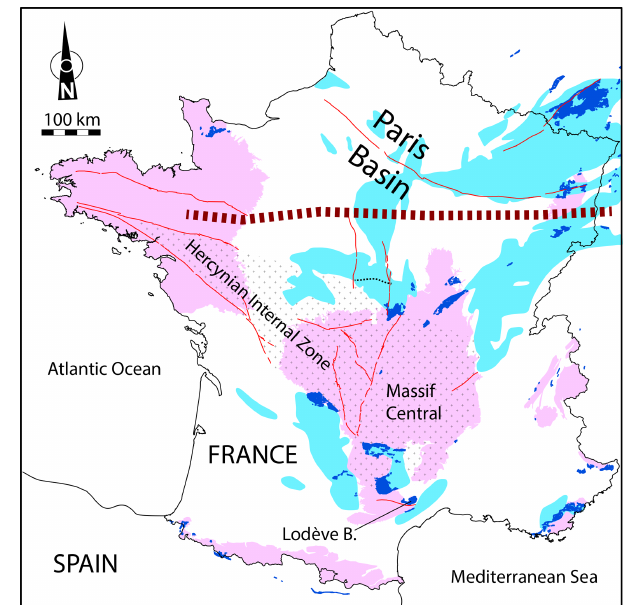
Figure 8. Top – simplified geology of France. Dark blue regions are basins with Permian strata exposed (e.g., Lodève), whereas light blue regions denote Permian strata buried by Mesozoic overburden. The bold dotted line crossing the E–W span of the Paris Basin is the location of the cross-section line in Fig. 9. The fine dotted line in the southern–central part of the basin is the location of the seismic line in Fig. 10 (modified from Beccaletto et al.,